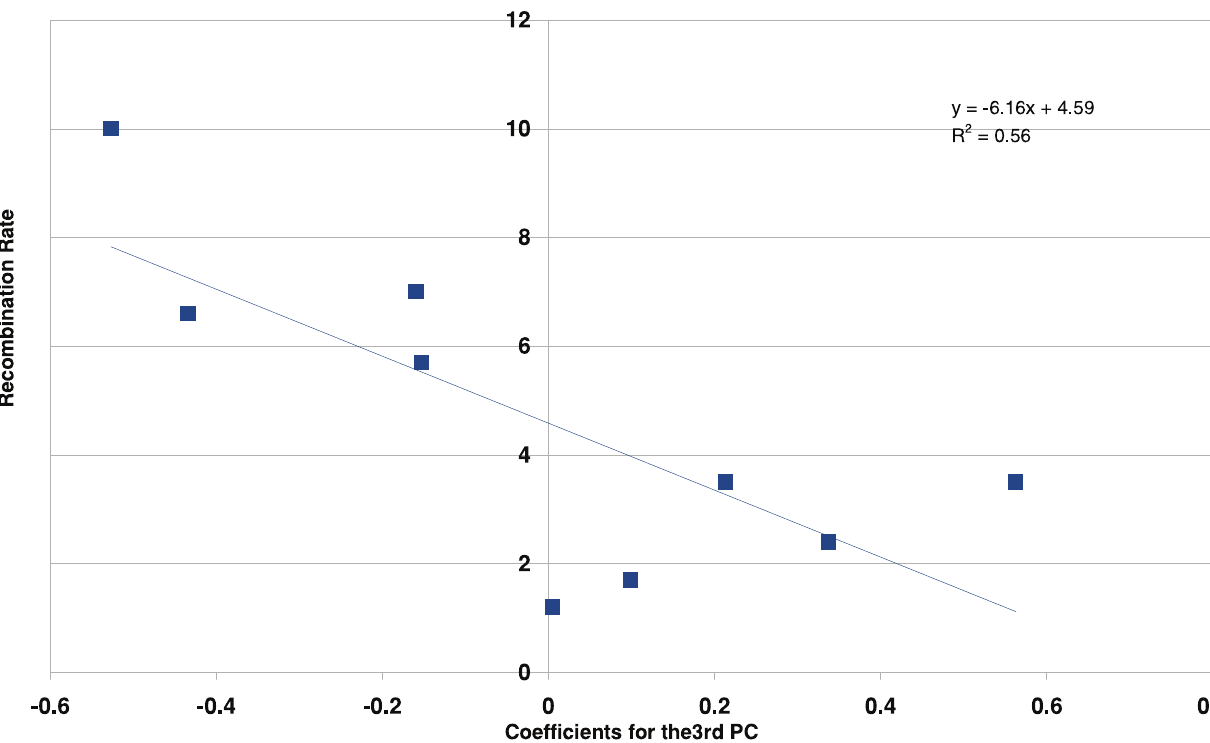
Figure 4. The correlation between the coefficients of the third principal component and the recombination rate.